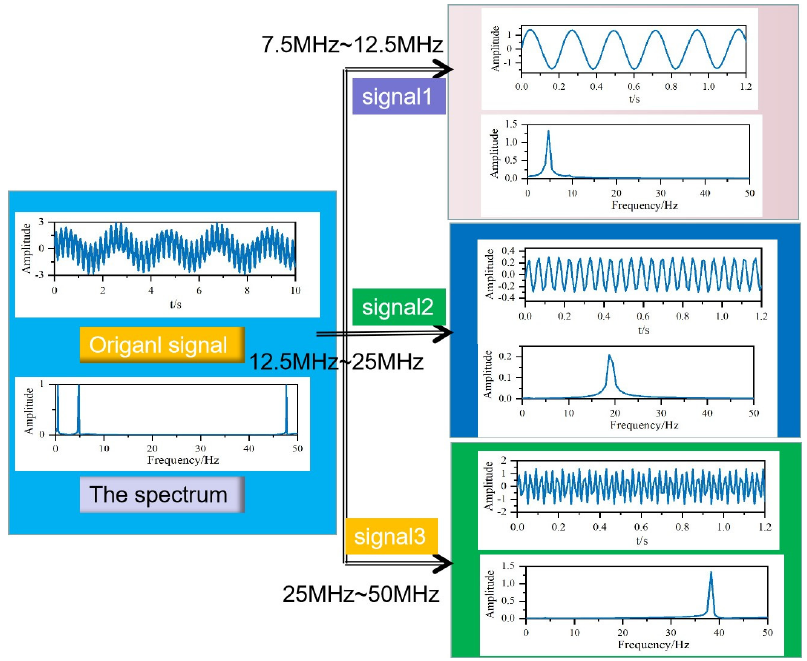
Figure 3. The decomposed signals using the wavelet transform.